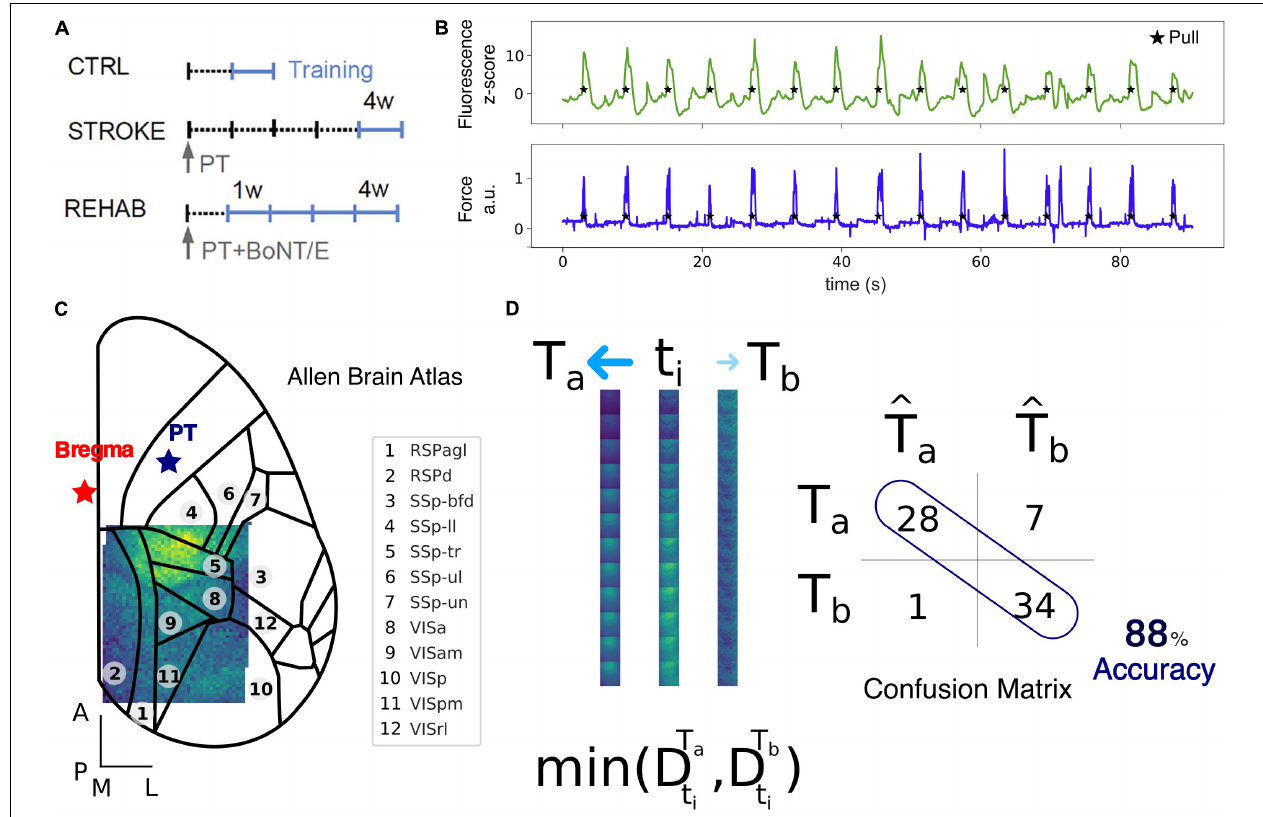
FIGURE 1 | Data collection and Nearest Centroid Euclidean Classifier (NCEC). (A) Experimental timeline for the Ctrl, Stroke, and Rehab groups. Light blue lines refer to training weeks. W, week; PT, photothrombosis; BoNT/E, botulinum neurotoxin E. (B) Example of fluorescence (green) and force (blue) traces simultaneously recorded during motor training on the M-Platform. (C) Field of view with overlaid cortical parcels according to the Allen Brain Atlas. The red star refers to bregma while the blue star refers to the site of photothrombosis. Scale bars in the bottom left corner are 1 mm in length. See Supplementary Table 1 for a list of the region acronym names. (D) Schematic representation of the NCEC. For the time window of interest, a single trial, t i , represented as a sequence of 12 frames, is assigned to the class template T a based on the minimum Euclidean distance between the trial and the template. Templates are generated as the average of all other trials for conditions a or b. The results of the classification for each trial are represented by the confusion matrix from which the accuracy can be calculated as the number of correctly classified trials over the total number of